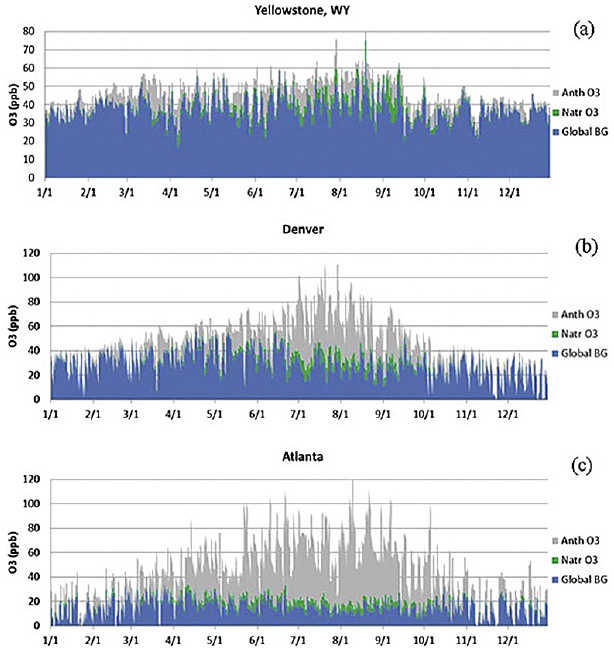
Figure 42. Modelled contributions of hourly GBO 3 (global tropo- spheric O 3 plus stratospheric O 3 ) , natural (Natr O 3 ) , and anthro- pogenic (Anth O 3 ) adding to total hourly O 3 for (a) Yellowstone National Park, (b) Denver and (c) Atlanta (Lefohn et al., 2014).